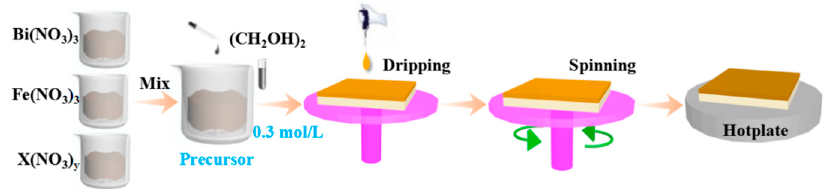
Figure 1. Schematic diagram of the process for preparing thin film via sol ‐ gel technology.